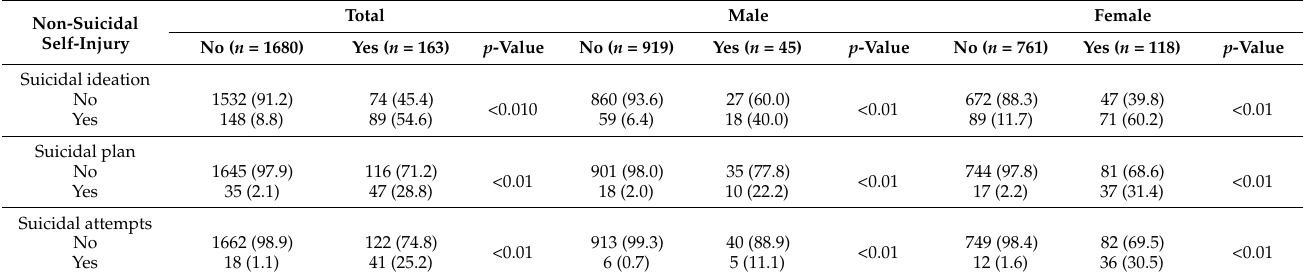
Table 2. Suicidal ideation, suicidal plan, and suicidal attempts rates according to non-suicidal self-injury by gender. Non-Suicidal Self-Injury